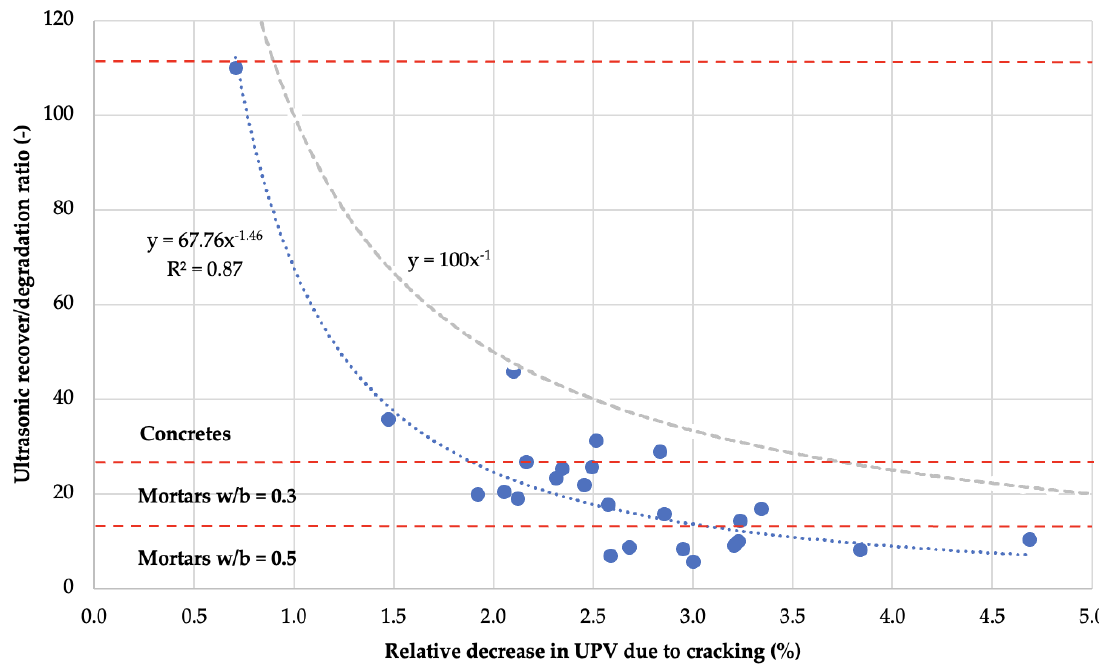
Figure 10. Graph of ultrasonic recover-to-damage ratio due to self-sealing after 122 days of curing versus relative changes in ultrasonic wave velocity due to mechanical induction of defects in concrete and mortar samples. The grey curve indicates the range of possible cases, assuming that the maximum ultrasonic self-sealing ratio is 100%.